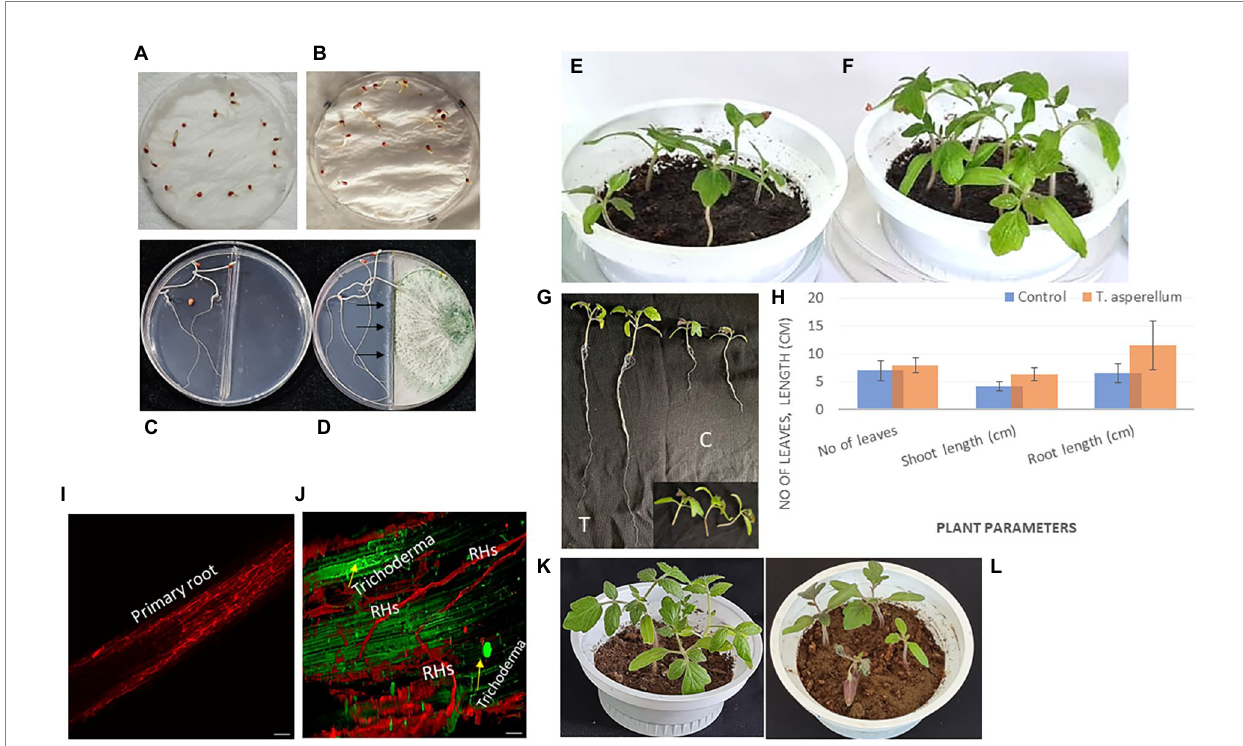
FIGURE 5 Trichoderma asperellum colonizes a tomato plant’s root system and promotes root elongation. (A) Seeds treated with distilled water. (B) Seeds treated with a spore suspension of T. asperellum . (C) Split interaction of seeds growing on water agar medium without Trichoderma treatment (control). (D) Split interaction with Trichoderma treatment. (E,F) Tomato plants are grown in the presence of Trichoderma after seed coating (pot at right) and without microbial inoculation (control only) (pot at left). (G) Promotion of root and shoot length via Trichoderma inoculation (T) compared to untreated plants (C). (H) Plant parameters include the number of leaves, shoot length, and root length with Trichoderma inoculation and control treatment. In vivo tests indicated the growth-promoting potential of this fungal endophyte. Trichoderma could boost plant growth by activating either an individual or numerous mechanisms. (I,J) Representative confocal laser scanning microscopical analysis illustrating the early and robust colonization of tomato roots/root hairs (RHs) by T. asperellum compared with the control (without microbial inoculation) using CLSM with a Leica TCS SP2. (K,L) Tomato plants are grown in the presence of T. asperellum after three weeks from seed coating (pot at left) and plants infected with Fusarium (pot at